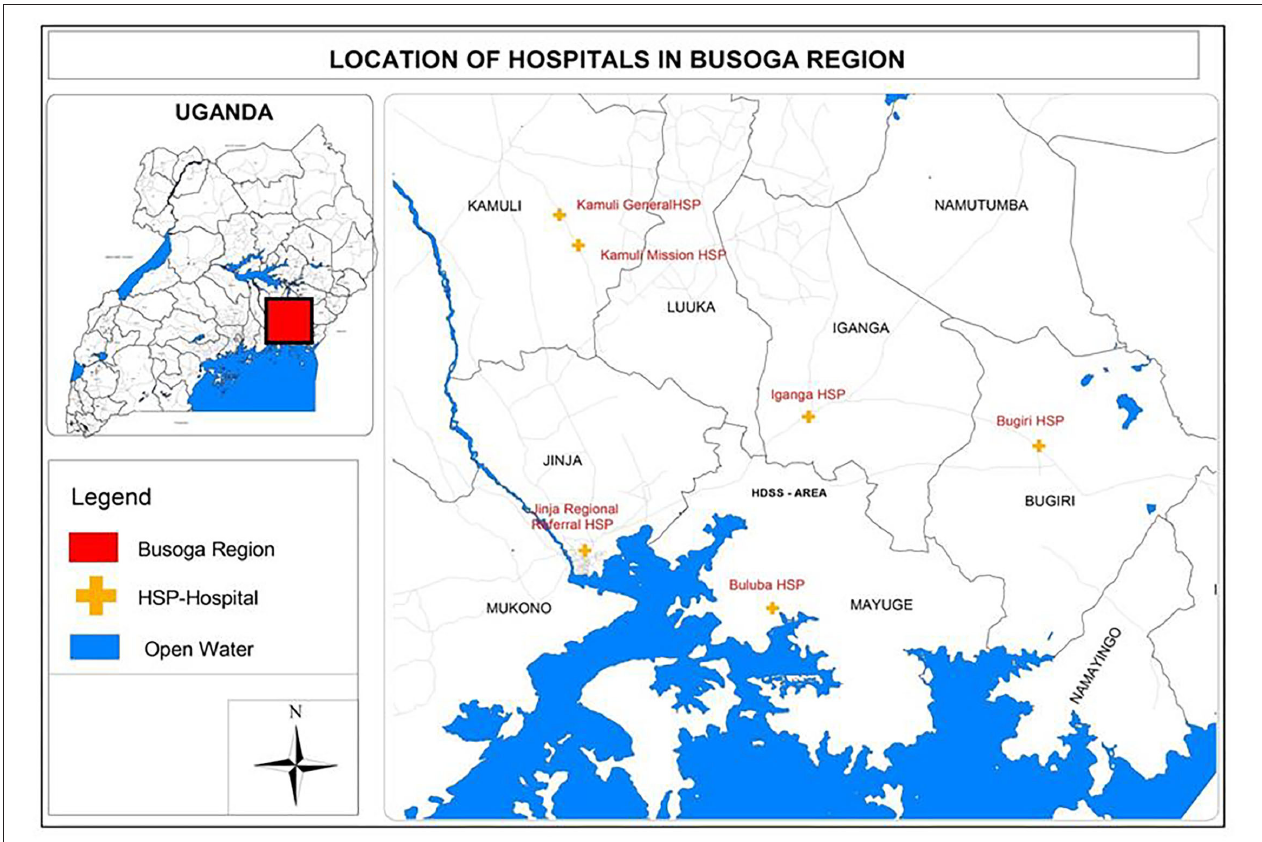
FIGURE 1 | Hospitals and communities where study was